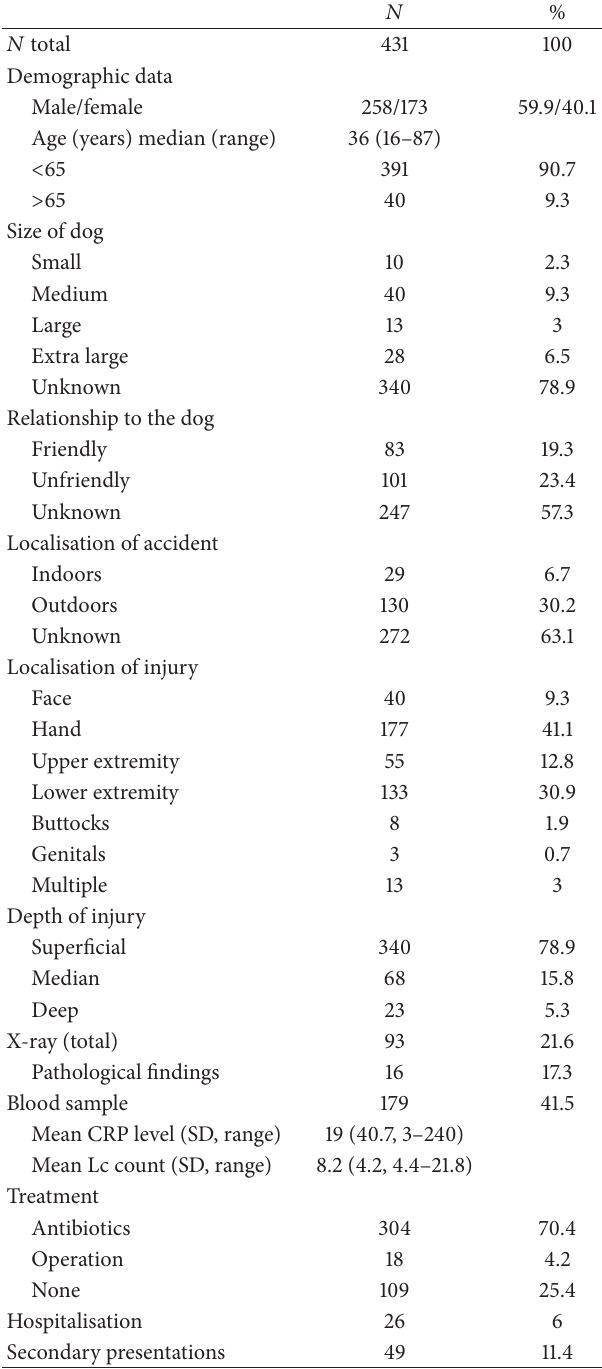
Table 1: Patient’s